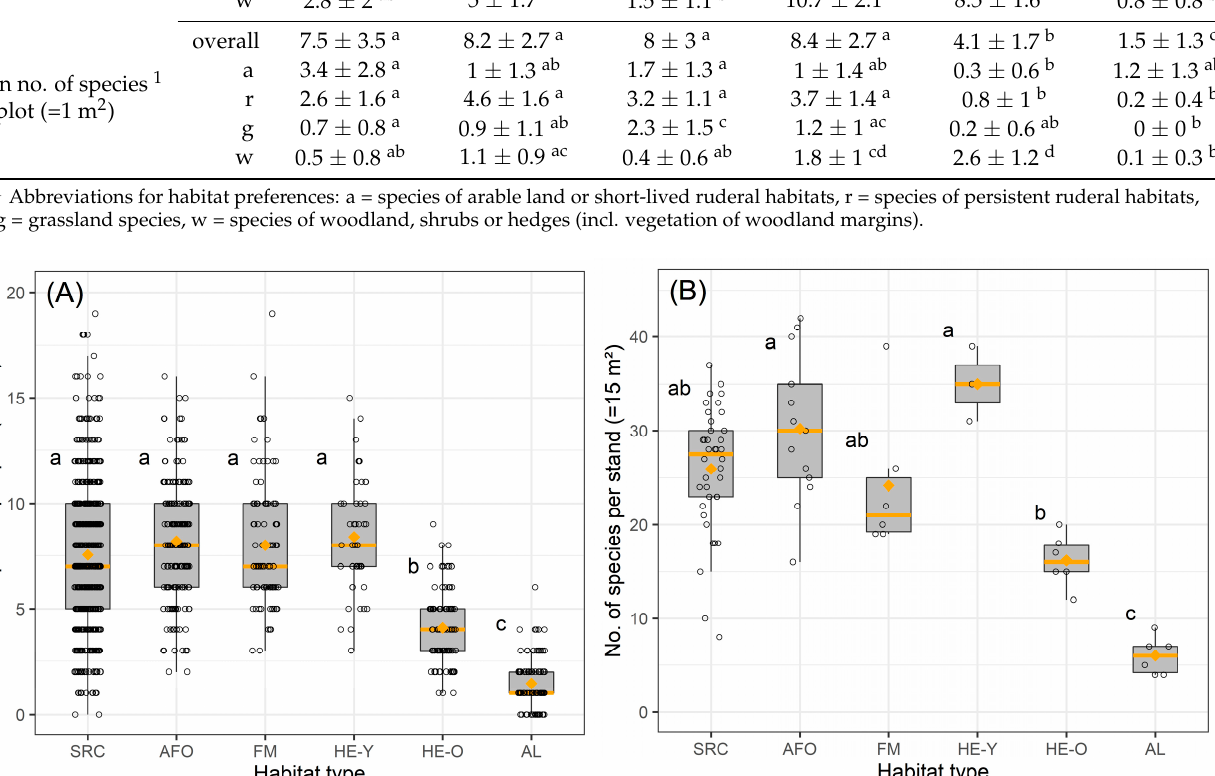
37 Figure 3. Estimated number of species for the different short-rotation coppice (SRC) and afforesta- tion (AFO) sites for a given number of sampled plots (based on sample-based rarefaction , see data preparation and statistical analysis). 3.1.2. Species Composition and Species Numbers with Regard to Habitat Preferences Figure 4 shows the species composition within the habitat types with regard to the habitat preferences of the detected species weighted with their frequencies. AL was dominated by species of arable land or short-lived ruderal habitats, while HE-O was dominated by species of woody habitats. The highest proportion of grassland species (almost 30%) was found in FM. SRC had high proportions of species from arable land or short-lived ruderal habitats (45%) and from persistent ruderal habitats (35%). With re-